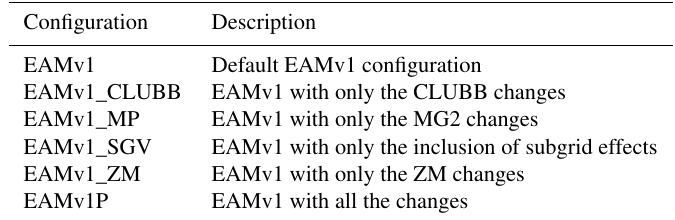
Table 5. List of model configurations.